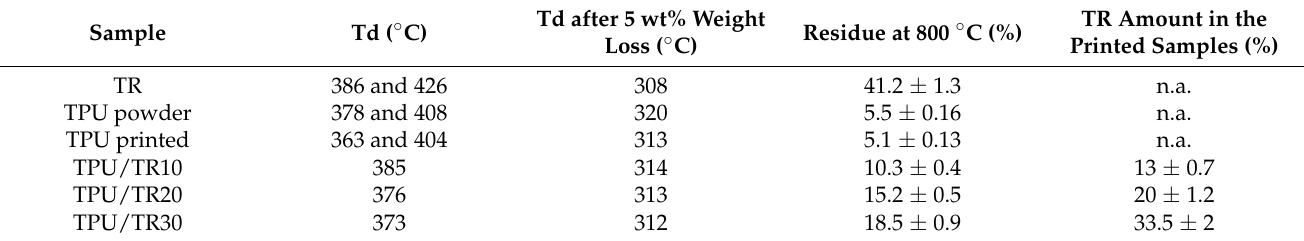
Figure 7. TGA thermograms of TPU, TR, and TPU/TR20 printed samples. Table 3. TGA analysis of TR, TPU/TR-based samples, and TR content in the printed